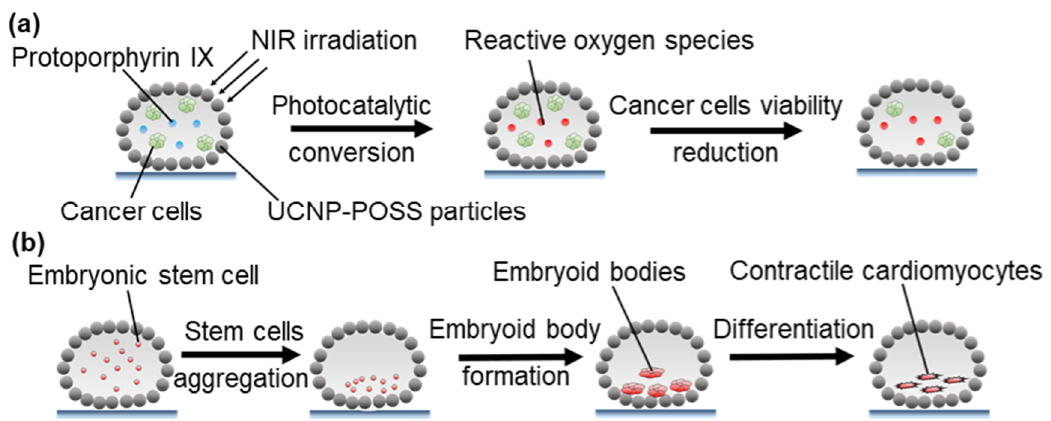
Figure 9. Cell cultures and treatments in liquid marble-based microbioreactors. ( a ) Photodynamic therapy treatment of a cancer cell in liquid marbles [72]. ( b ) Formation of embryoid bodies and differentiation into cardiac cells in liquid marbles [45]. NIR: near infrared. UCNP-POSS: upconversion nanoparticles-polyhedral oligomeric silsesquioxane.